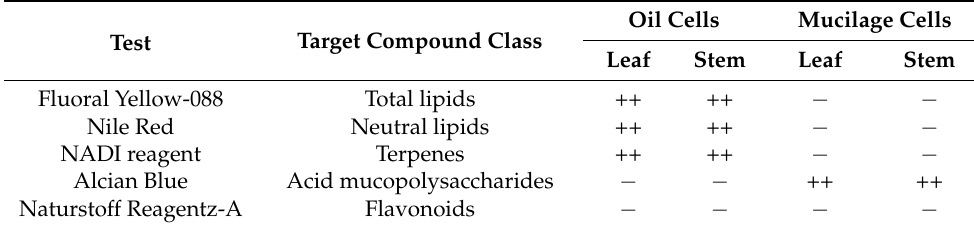
Table 1. Results of the histochemical analysis on the leaves and young stems of Cinnamomum camphora .